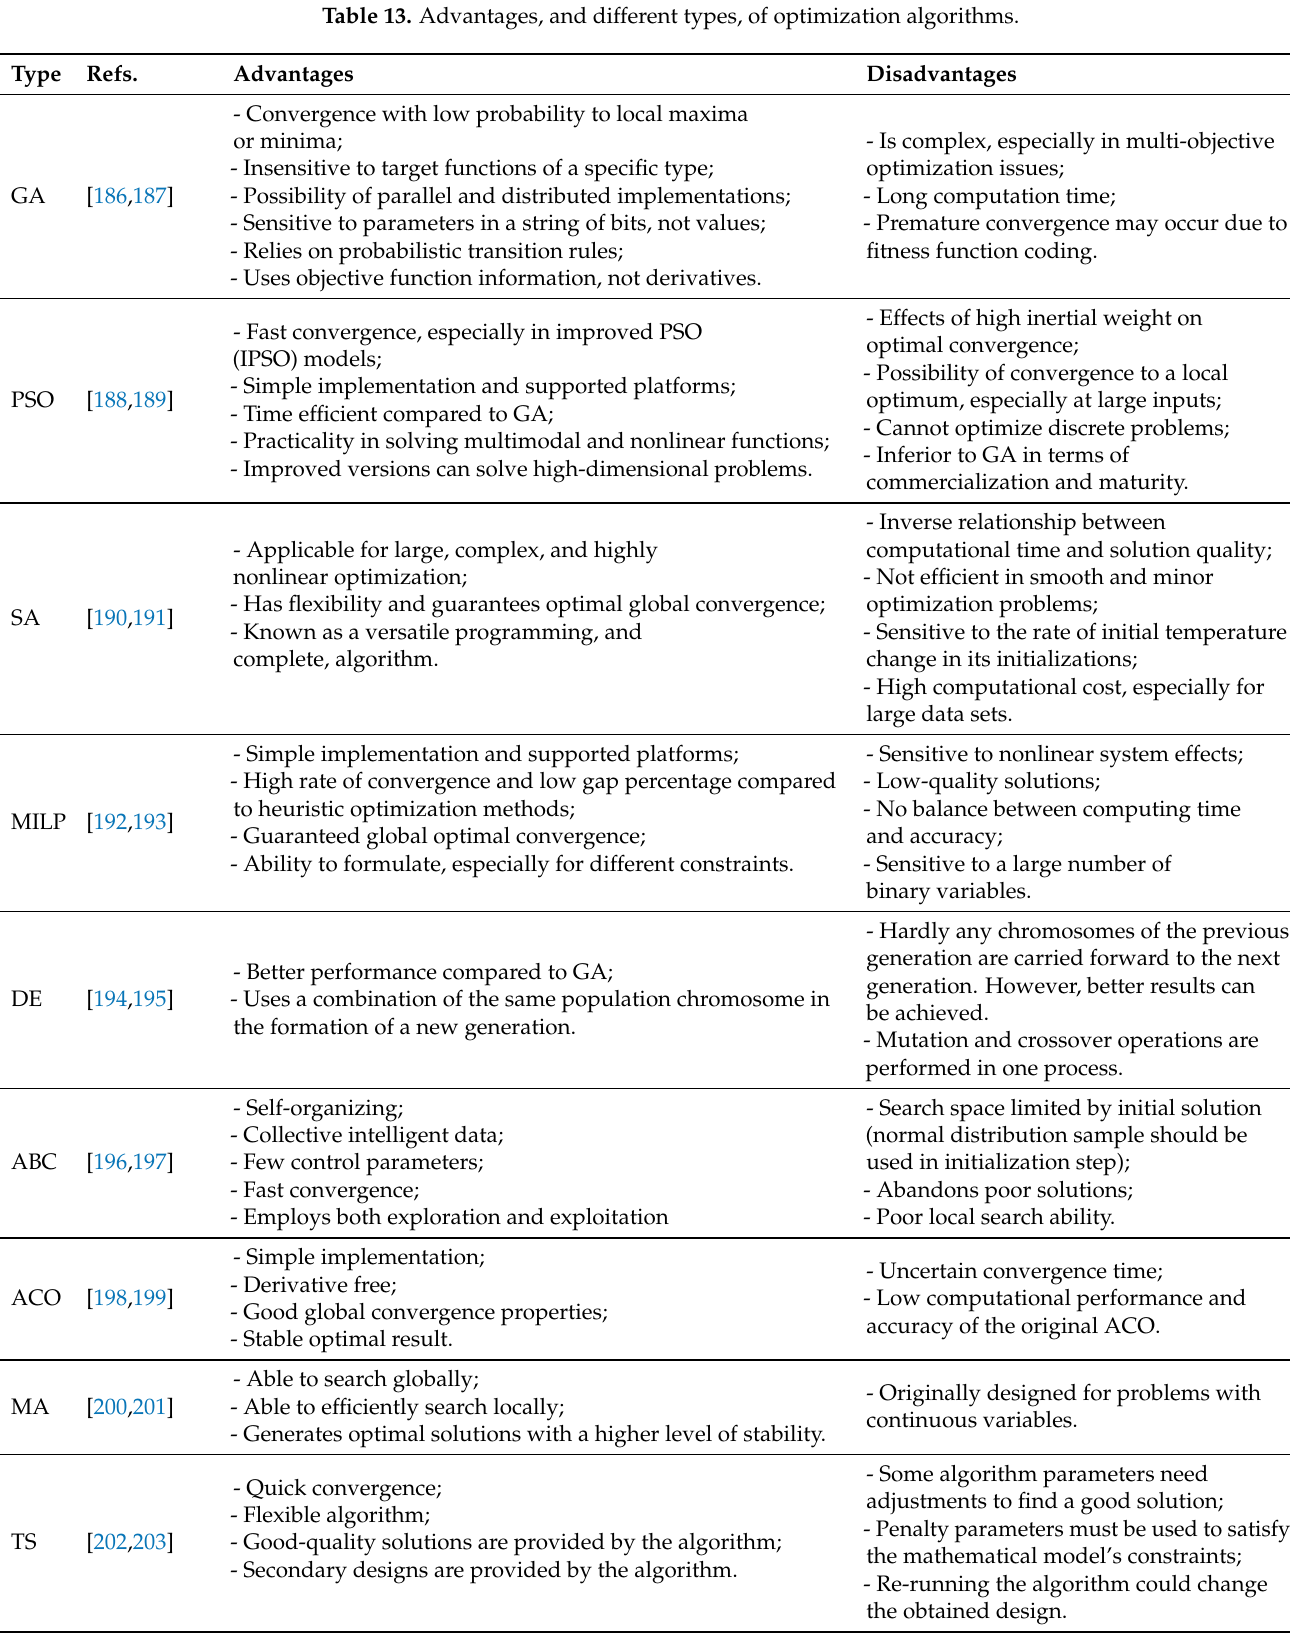
Table 13. Advantages, and different types, of optimization